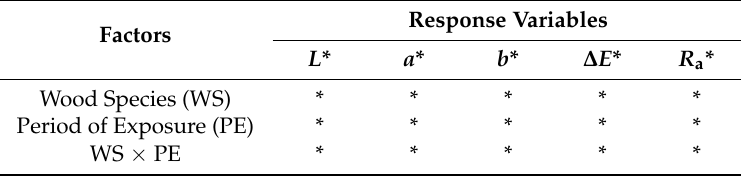
Table 3. Results of multifactorial ANOVA test (* denotes p < 0.05). Factors